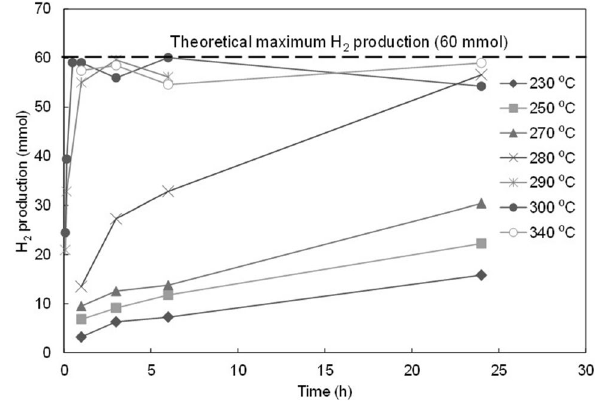
Fig. 3 Hydrogen production from reactions using aluminum powder